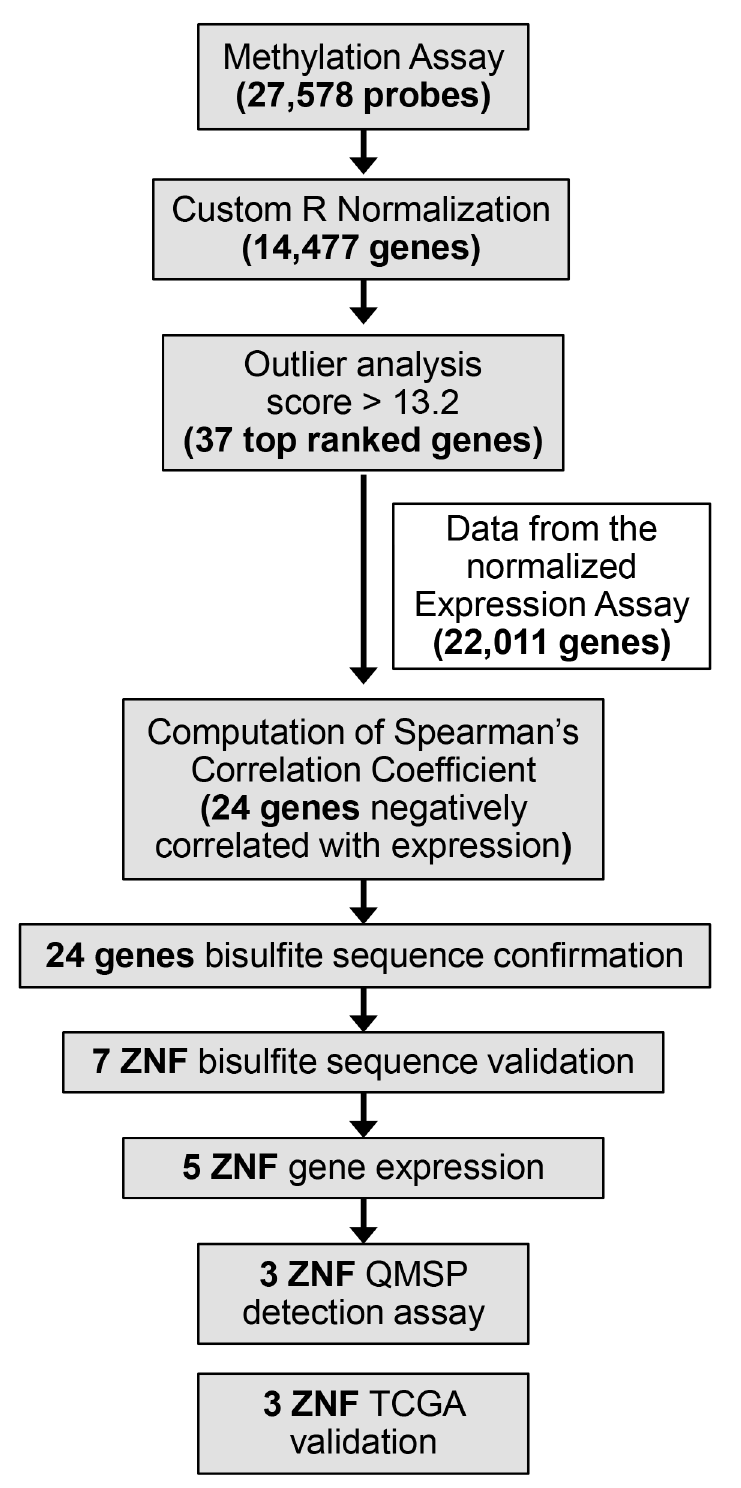
Fig 1. Integrative methylation screening strategy. Schematic outline of the integrative approach utilized in this study, which combines high-throughput screening of DNA methylation and gene expression for the discovery cohort of HNSCC: employment of DNA methylation array data with 27,578 probes total;